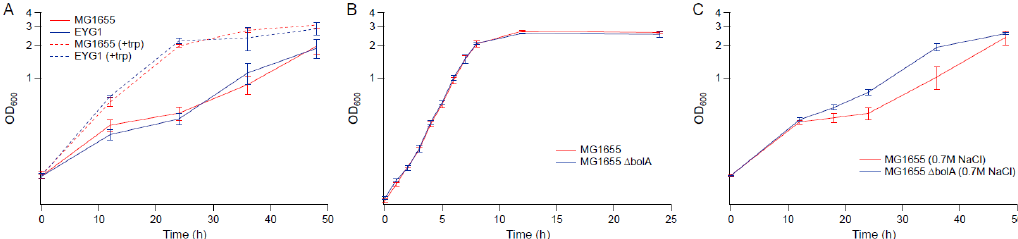
Figure 11. Growth kinetics of MG1655, EYG1 and the knockout strains in MG1655 background. ( A ) M9 supplemented with 0.7 M NaCl with and without 50 µg mL −1 tryptophan ( B ) M9 ( C ) M9 supplemented with 0.7 M NaCl. Error bars are standard deviations.